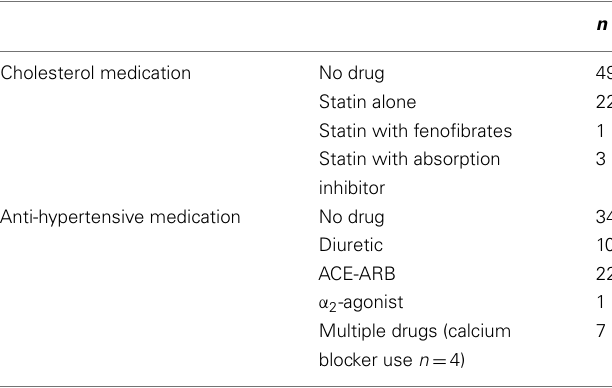
Table 1 | Cholesterol and anti-hypertensive medication profiles of